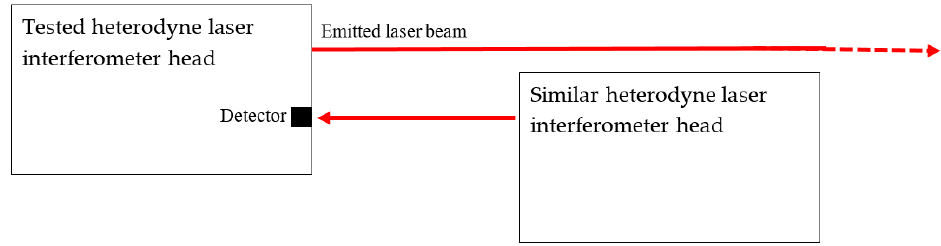
Figure 5. Checking the counting system of a heterodyne laser interferometer using a similar laser interferometer to generate a detected speed.